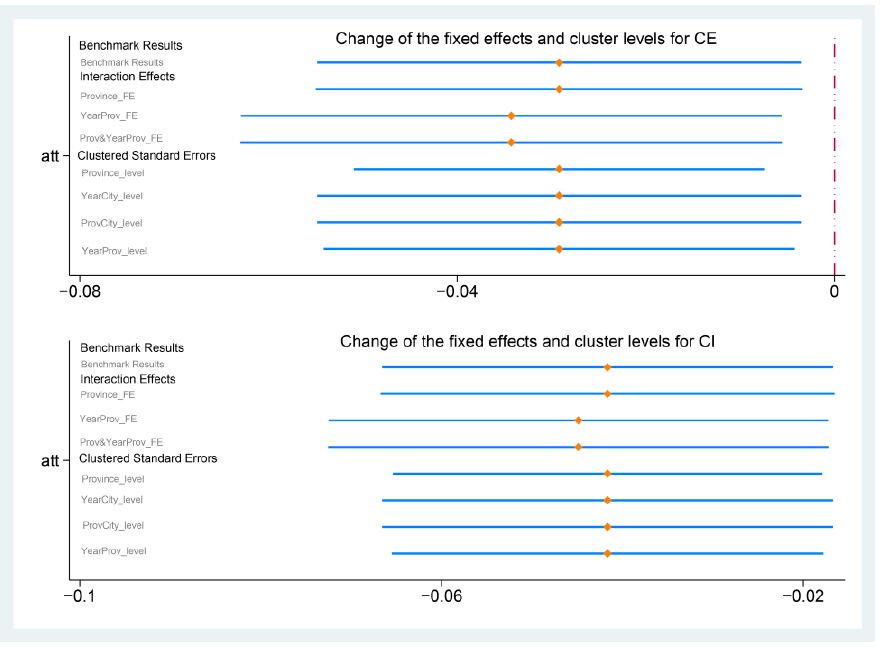
Figure 2. Change of the fixed effects and cluster levels for CE, CI.